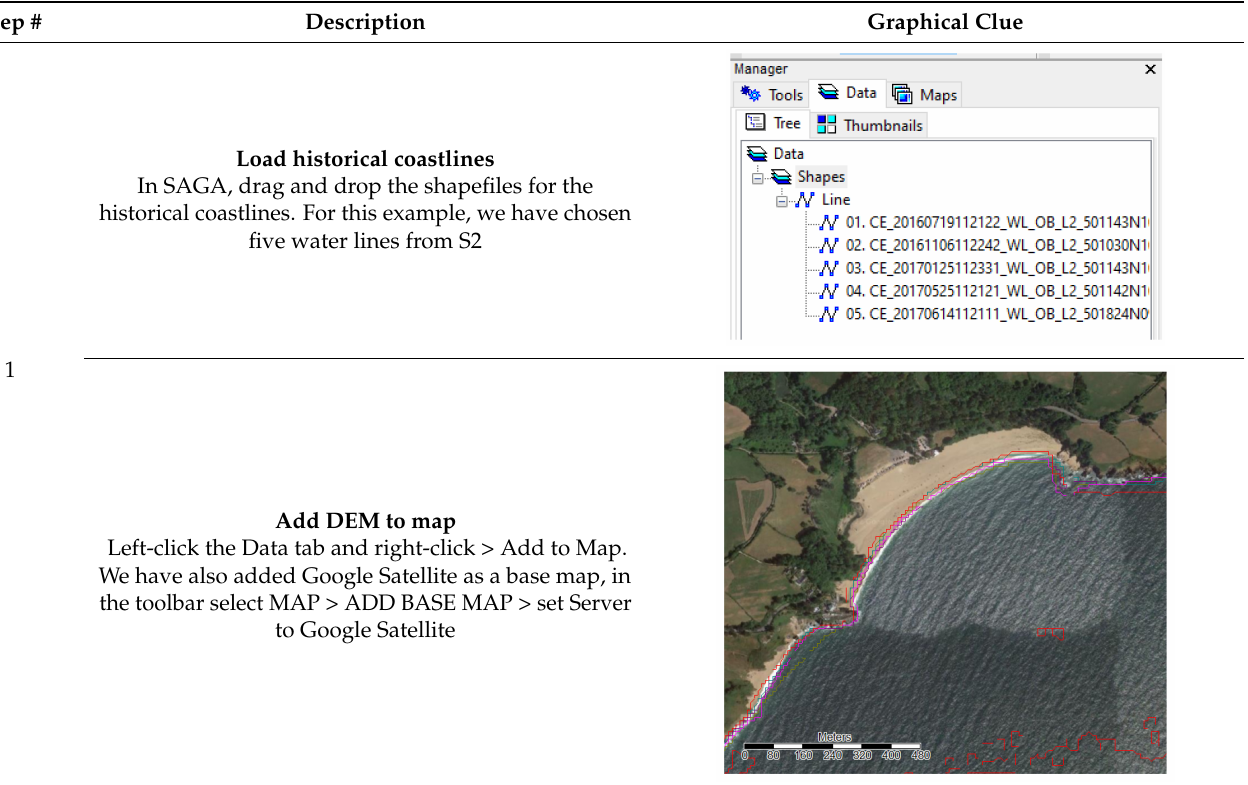
Table A1. Step by step guidelines to use ODSAS for shoreline change